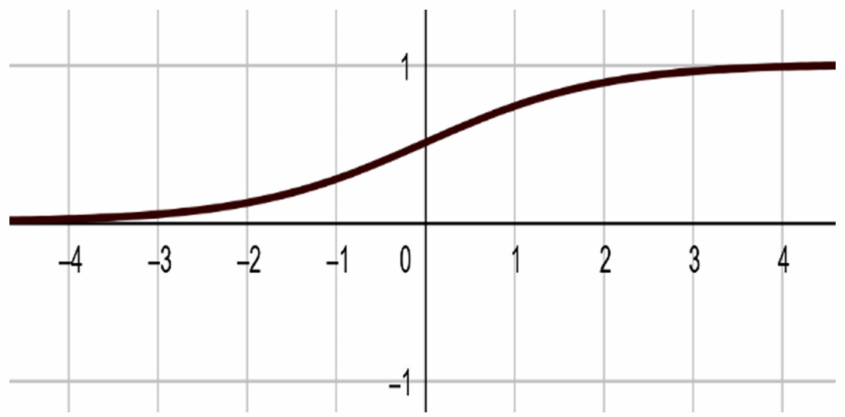
Figure 2. Sigmoid